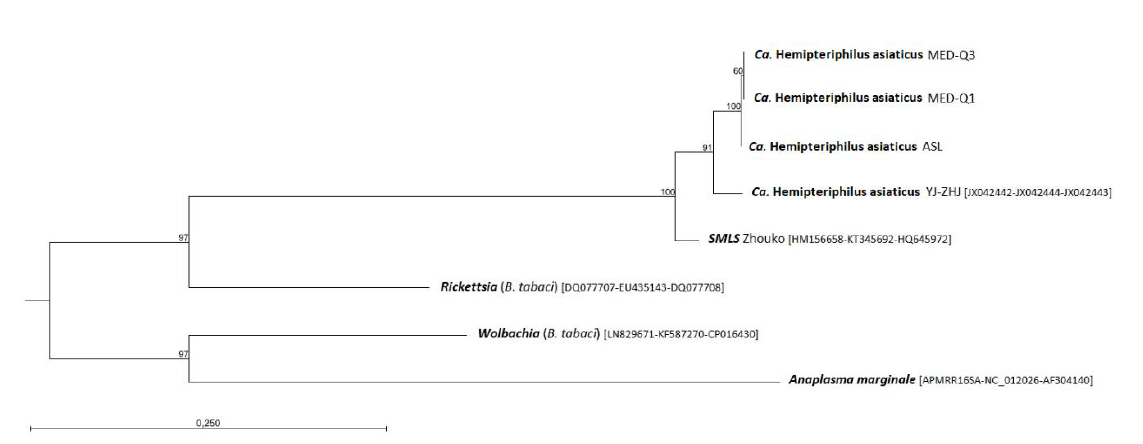
Figure 2. Phylogeny constructed using Maximum Likelihood analysis (model GTR + G + T) based on the trimmed and concatenated sequences of three genes, 16S rRNA (483bp), GroEL (269bp) and GltA